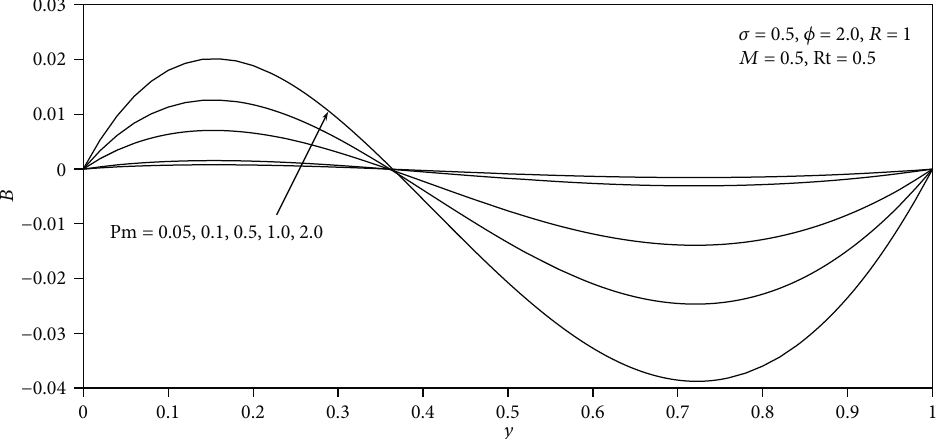
Figure 7: Induced magnetic fi eld for di ff erent values of the magnetic Prandtl number Pm .